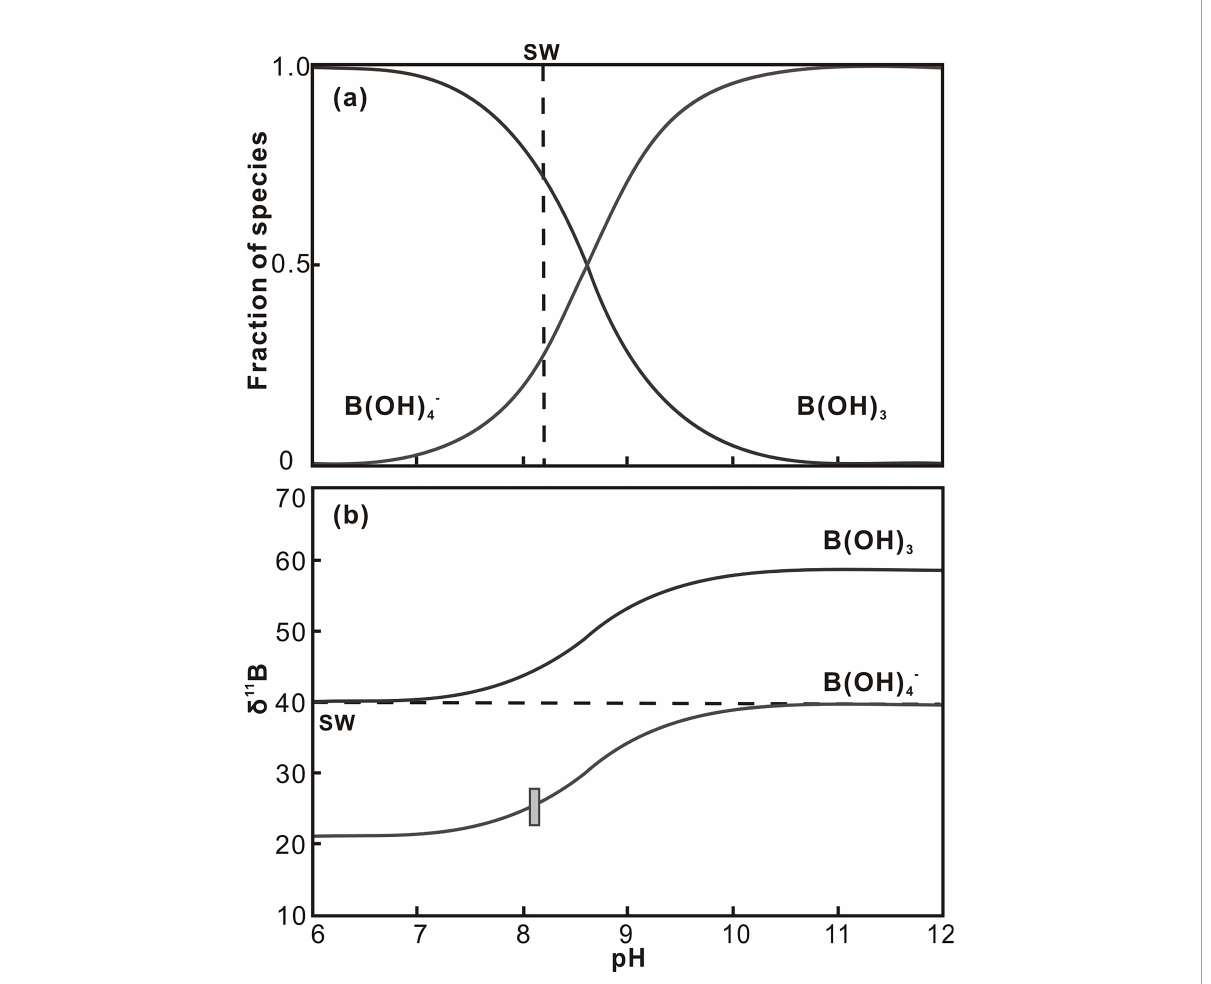
FIGURE 1 Distribution of (A) aqueous boron species and (B) boron isotopic composition as a function of pH in solutions. Note that the dashed line indicates modern seawater pH (~8.2), and the d 11 B of modern carbonates falls near the theoretical line of B(OH) 4 −